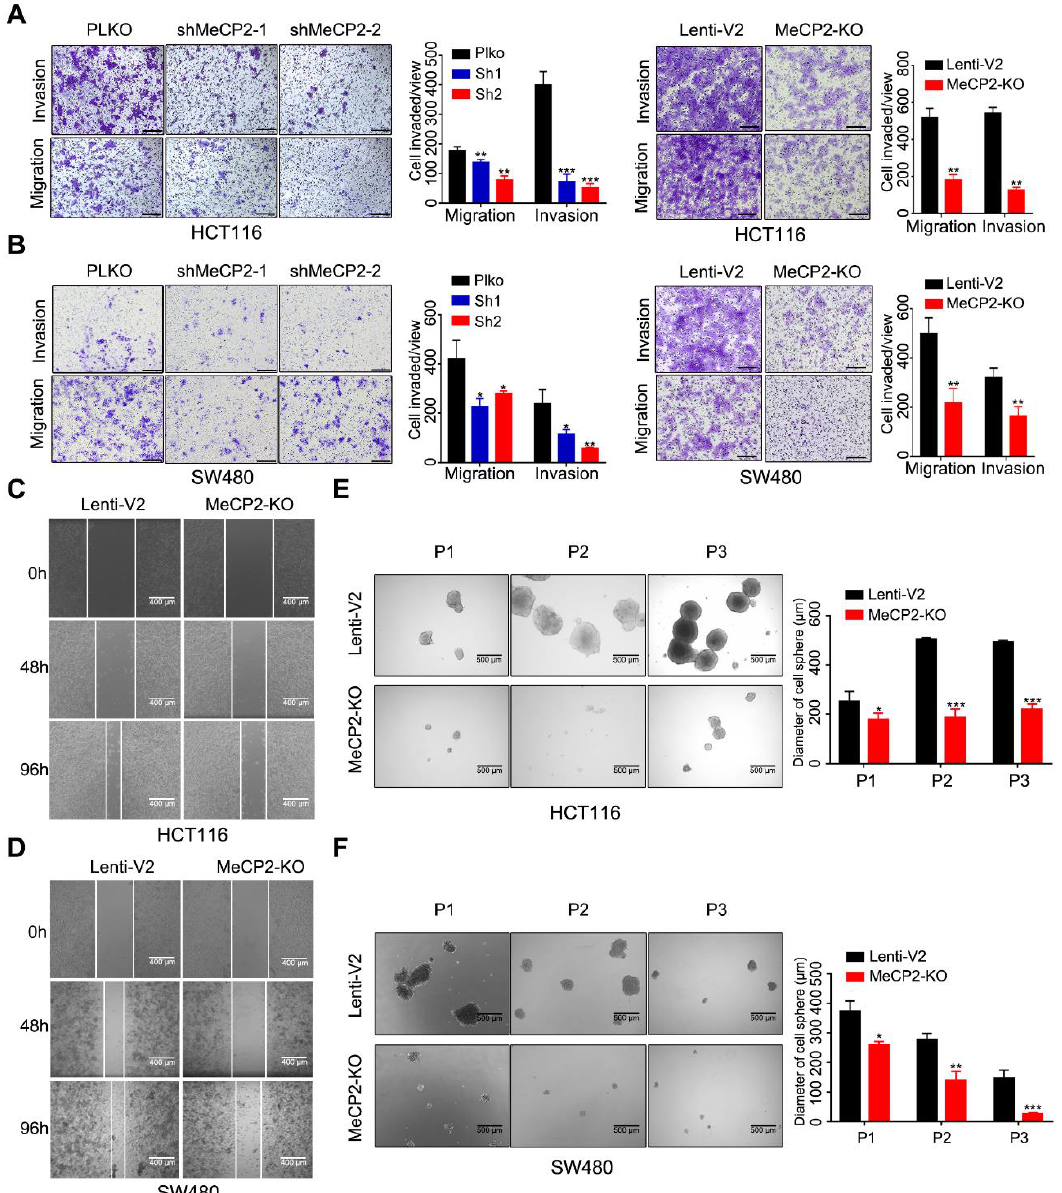
Figure 3. Abrogation of MeCP2 inhibits colorectal cancer (CRC) cell migration, invasion, and stemness. ( A ) MeCP2 knockdown and knockout inhibited HCT116 cell migration and invasion in a Transwell assay. Representative images (left) and quantitative analyses (right) are shown. ( B ) MeCP2 knockdown and knockout inhibited SW480 cell migration and invasion in a Transwell assay. Representative images (left) and quantitative analyses (right) are shown. ( C ) Knockout of MeCP2 in HCT116 cells suppressed migration in a wound-healing assay. Representative images are shown. ( D ) Knockout of MeCP2 in SW480 cells suppressed migration in a wound-healing assay. Representative images are shown. ( E , F ) Representative images and quantification of the in vitro sphere-formation assay of MeCP2 knockout in CRC cells and control cells ( n = 6). P1: Passage 1, P2: Passage 2, P3: Passage 3. Scale bar: 200 µ m. * p < 0.05, ** p < 0.01, *** p < 0.001 (Student’s t -test).